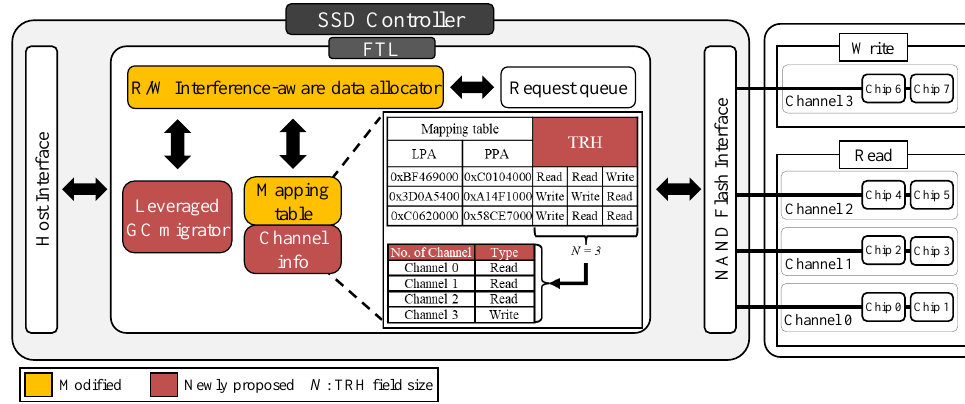
Figure 2. Overview of the parallelism-aware channel partition